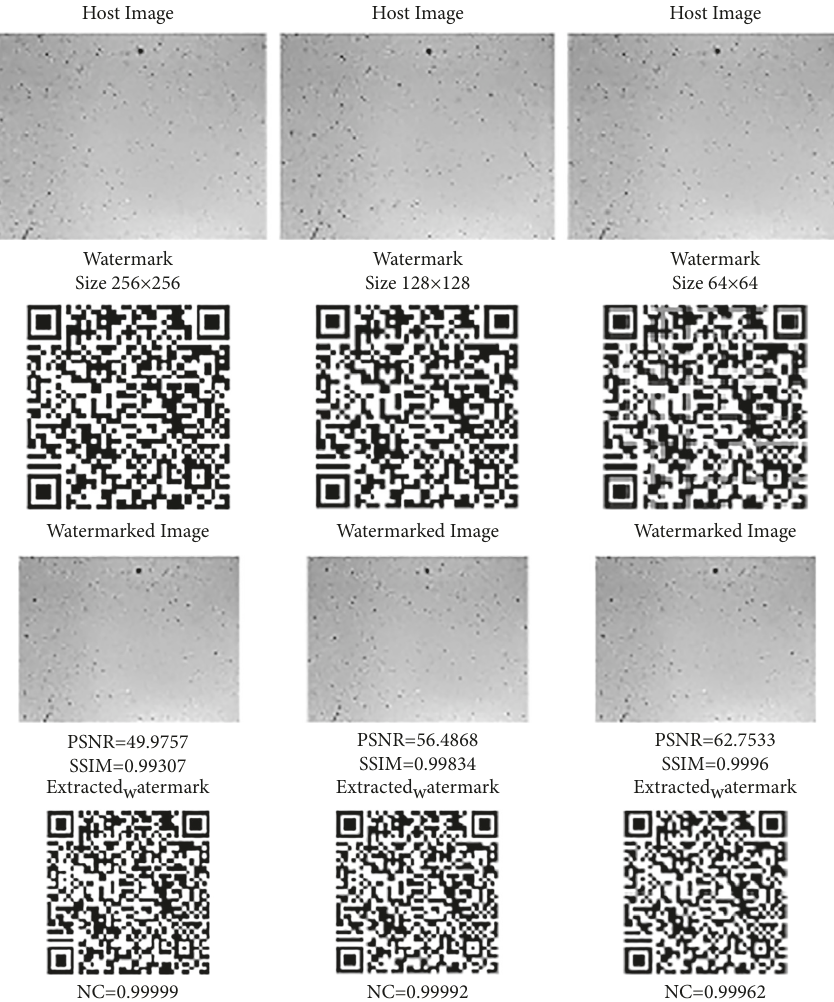
Figure 18: Invisibility performance of cancer cell line image.